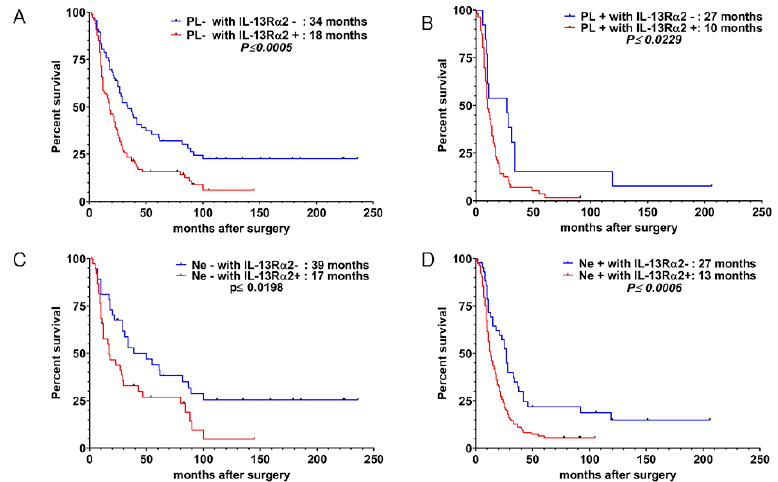
Figure 4. Kaplan–Meier survival curve of patients after pancreatic cancer resection. Survivals were compared between patients with ( A ) PL − with IL-13R α 2 − vs. PL − with IL-13R α 2 + ,( B ) PL + with IL-13R α 2 − vs. PL +/ IL-13R α 2 + ( C ) Ne − with IL-13R α 2 − versus Ne − with / IL-13R α 2 + ; and ( D ) / Ne + with IL-13R α 2– vs. Ne + with IL-13R α 2 + PDAC tumors.